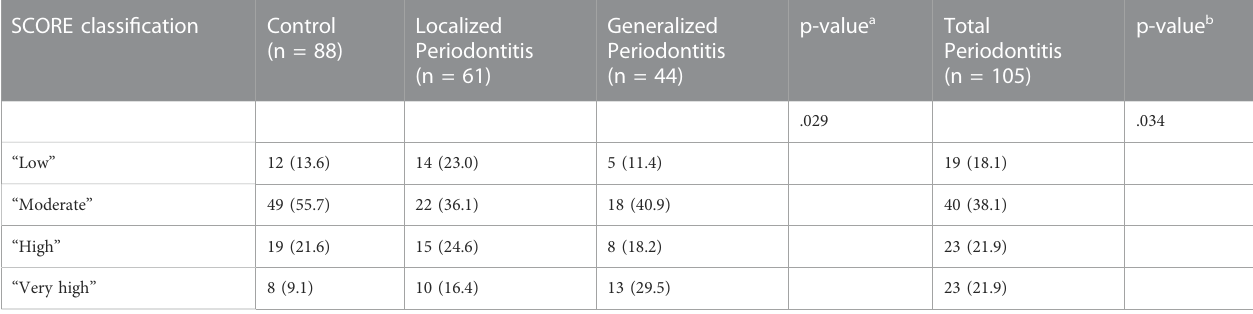
TABLE 6 Cardiovascular risk assessment with SCORE: 10-year risk on CVD